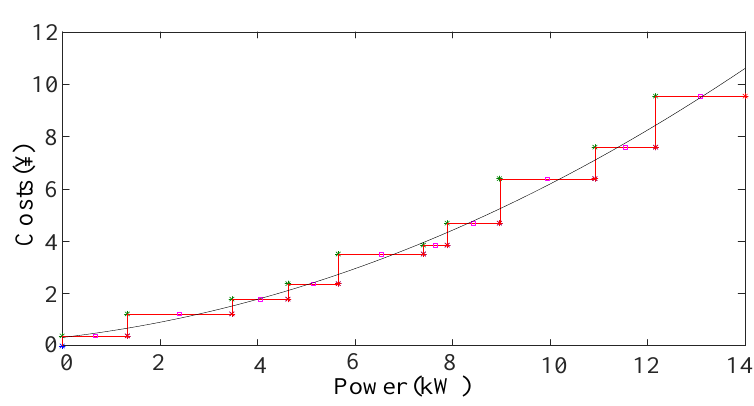
Figure 4. The fitting function plot of Customer